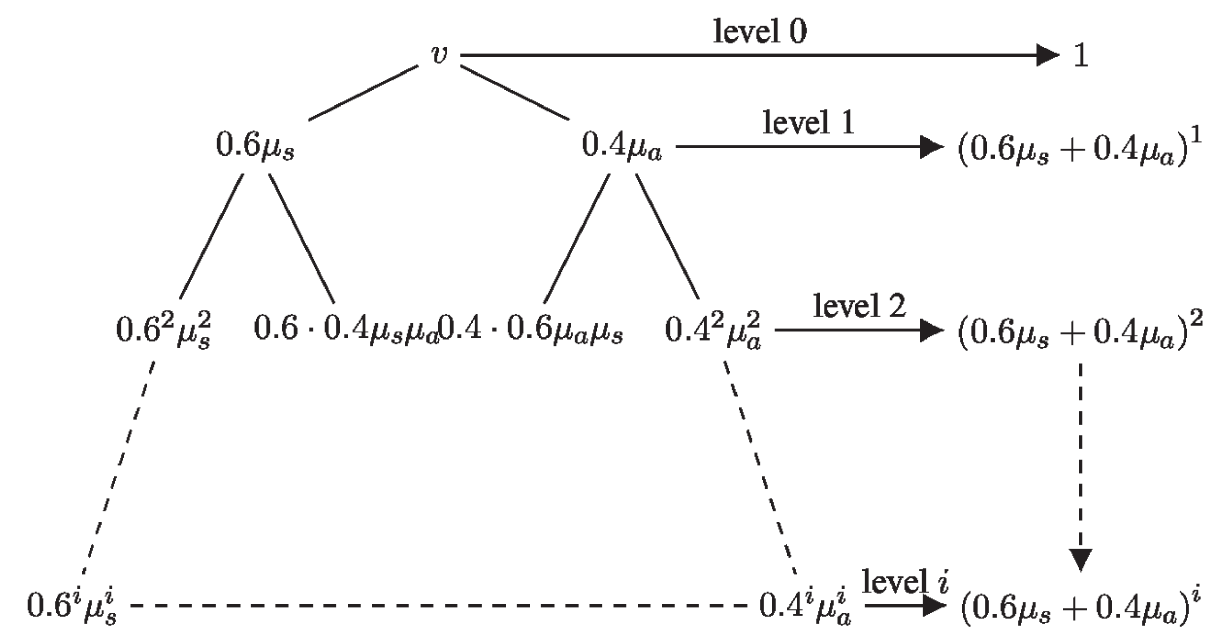
Fig 1. Illustrating the branching process analysis. The right hand side displays the total expected number of infected people at each level.